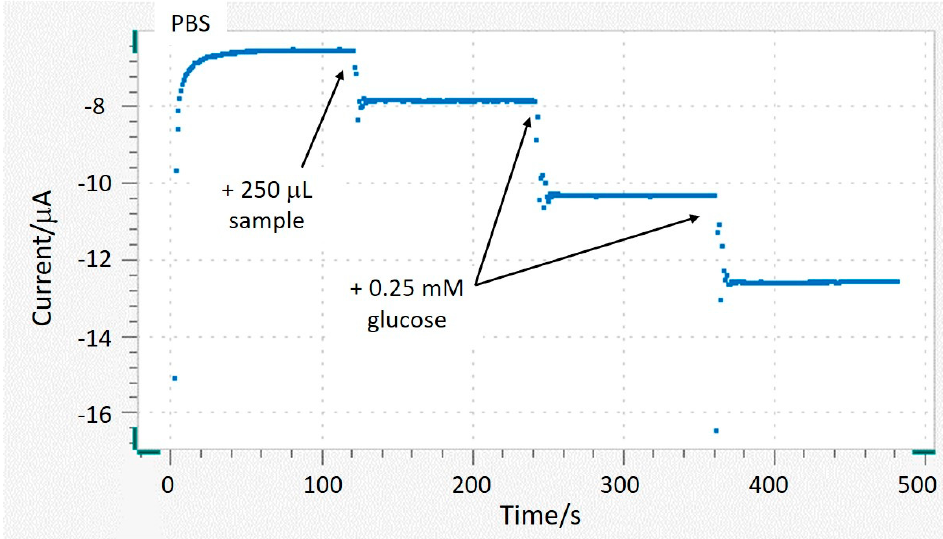
Figure 4. Current-time plot of the Ti/TiO 2 NTAs/ppHEMA-co-EGDA/pgPFM/GOx/Chitosan biosensor with an applied potential of -0.4 V when 250 mL of sample and two additions of 0.25 mM glucose injections were made.